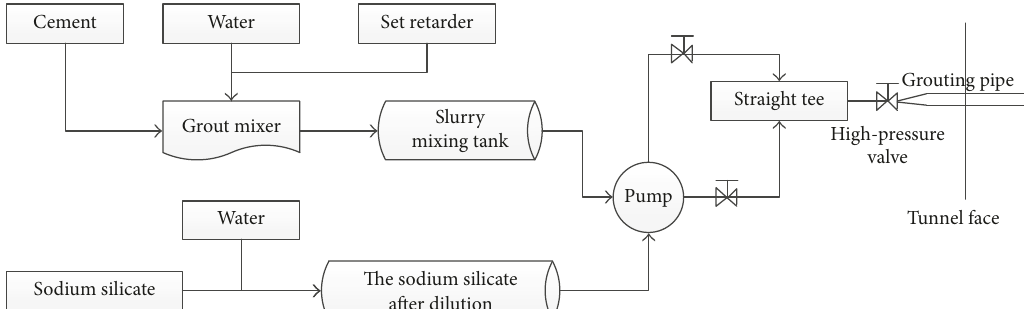
Figure 16: Grouting pipe connections.